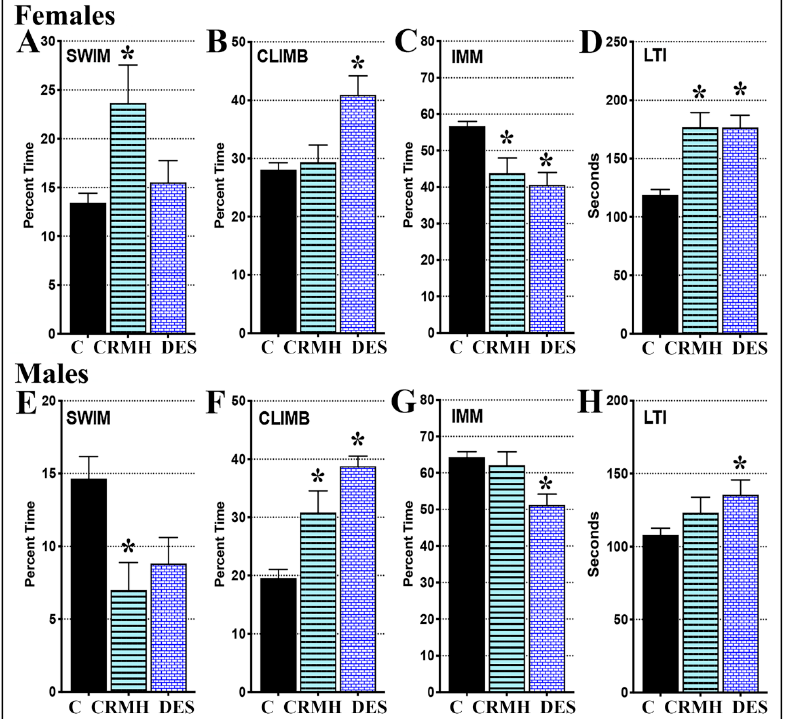
Figure 7. Dietary CRMH has antidepressant effects in the forced swim test in female rats at altitude but not males. In females at altitude, dietary CRMH significantly ( A ). increased swimming, ( B ). did not change climbing, ( C ). decreased immobility and ( D ). increased LTI vs. controls. Antidepressant efficacy of dietary CRMH in females was on par with that of the TCS desipramine (DES). In males at altitude, dietary CRMH significantly ( E ). decreased swimming, ( F ). increased climbing, and did not alter ( G ). immobility or ( H ). LTI (one-way ANOVA, * = p <0.05 vs. controls).